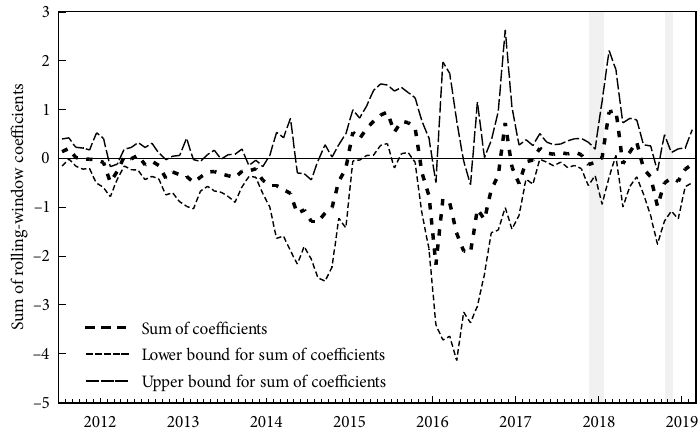
Figure 5. Bootstrap estimates of the sum of the rolling-window coefficients for the impact of BP on